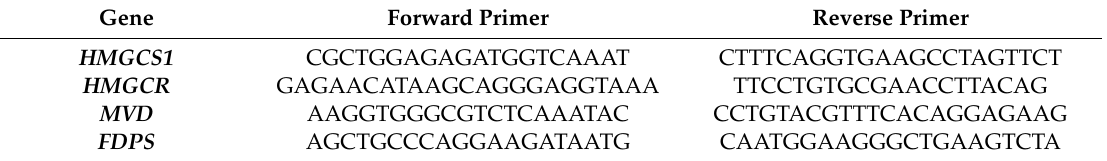
Table 2. Primer sequences for chromatin immunoprecipitation